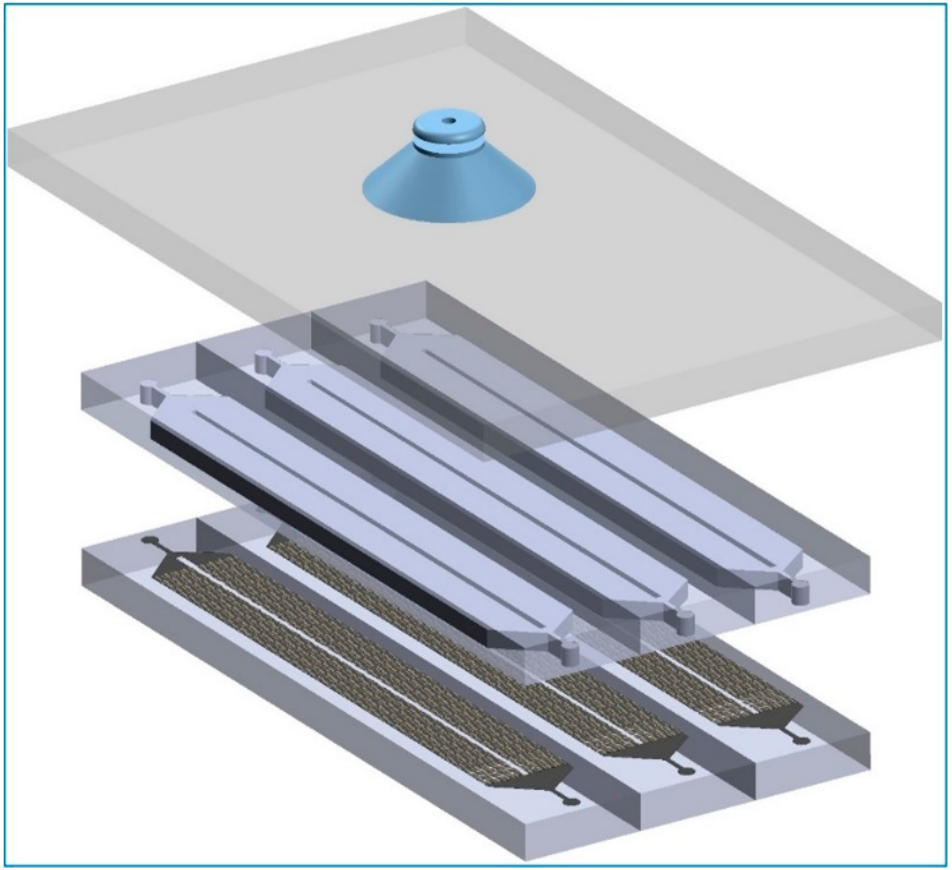
Figure 4. Schematic of the arrangement of the PDMS slabs (wafer ‐ scale) alignment. The innovations stay on (i) usting the electrostatics for binding the top slab to a glass plate and (ii) using the vacuum tweezer connected to a XYZR stage to manipulate the movement glass plate, hence the top slab. The bottom slab sits on a rotational stage, which gives us the freedom to also adjust the alignment